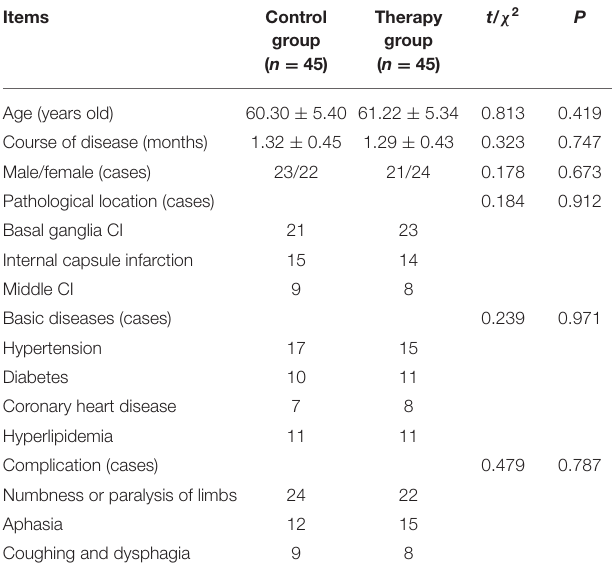
TABLE 1 | Comparison of general information between the two groups of patients.